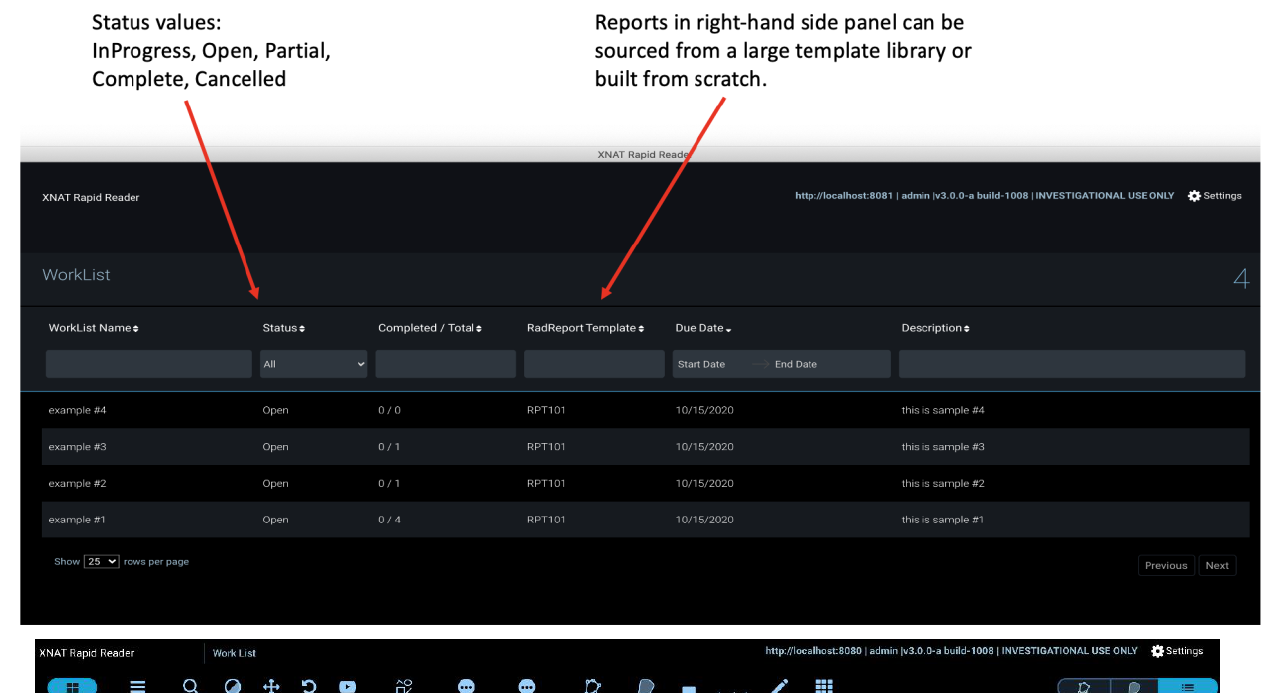
Figure 6. The new image composition tool, allowing overlay of DICOM series within a session to display, for example, PET-CT images.